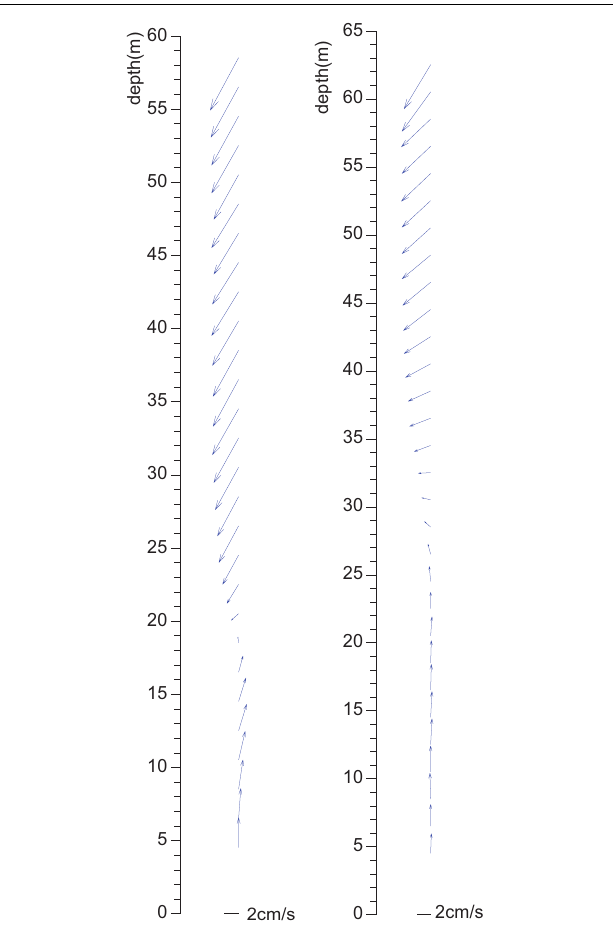
FIGURE 5 | The monthly mean current profiles of M4-2007AUT (left) and M5-2007AUT (right) (depth 0 m indicating bottom).